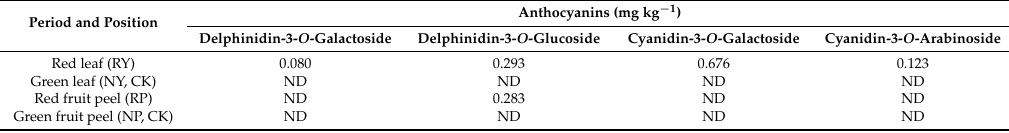
Table 1. Anthocyanin concentrations in red and green walnut tissues at fruit ripening